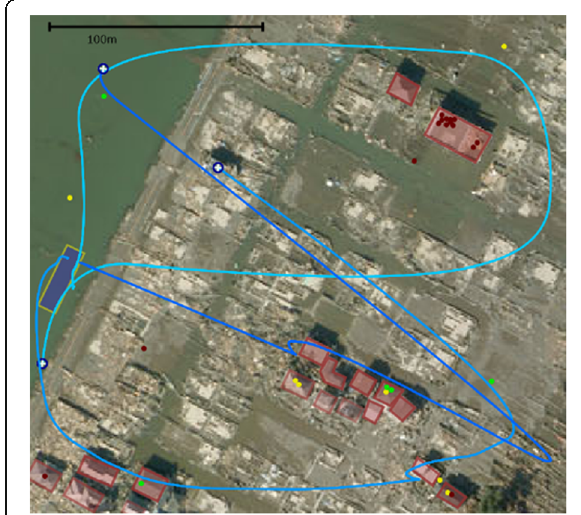
Fig. 7 Scatter method showing the paths of three UAVs. As with standard method, robots launched from the blue rectangle. However, each UAV proceeded to a different location in the search pattern, scattering them across the area. Photograph by GSI of Japan (Geospatial Information Authority of Japan 2011)